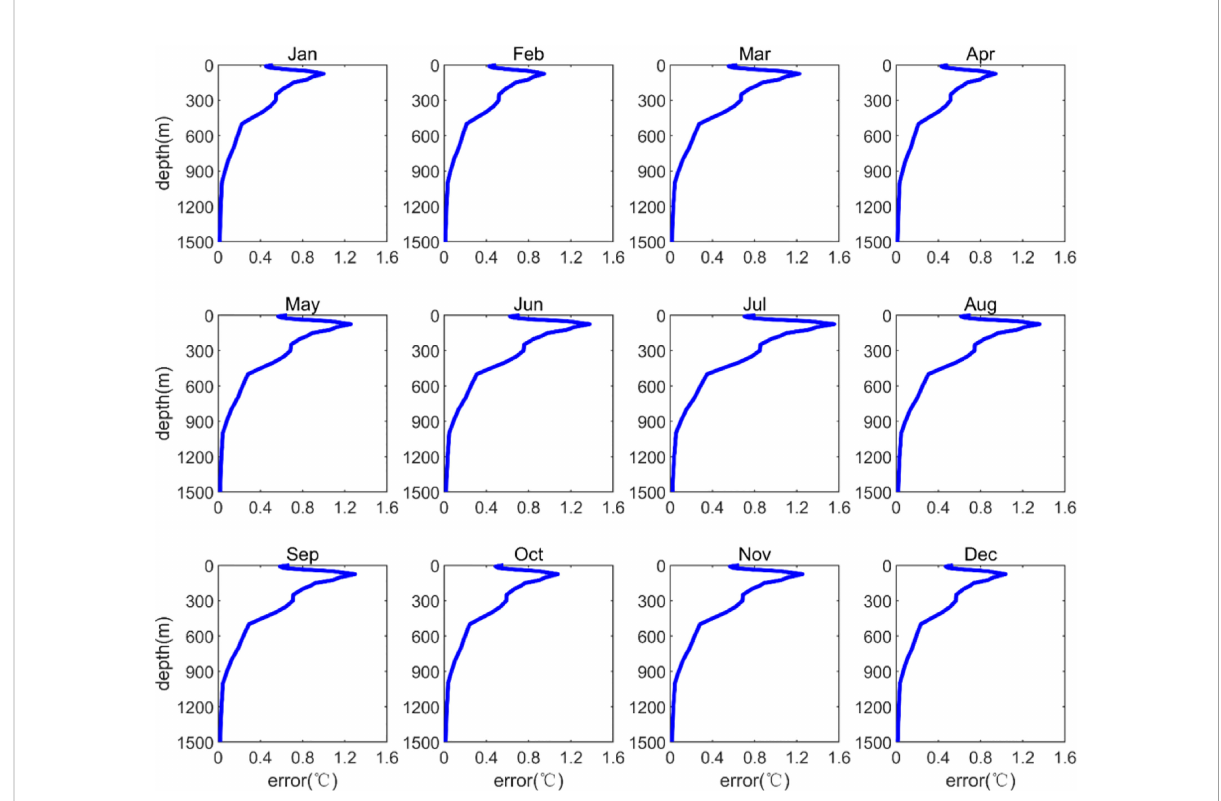
FIGURE 6 Vertical distribution of expanded temperature fi eld monthly errors in the northern South China